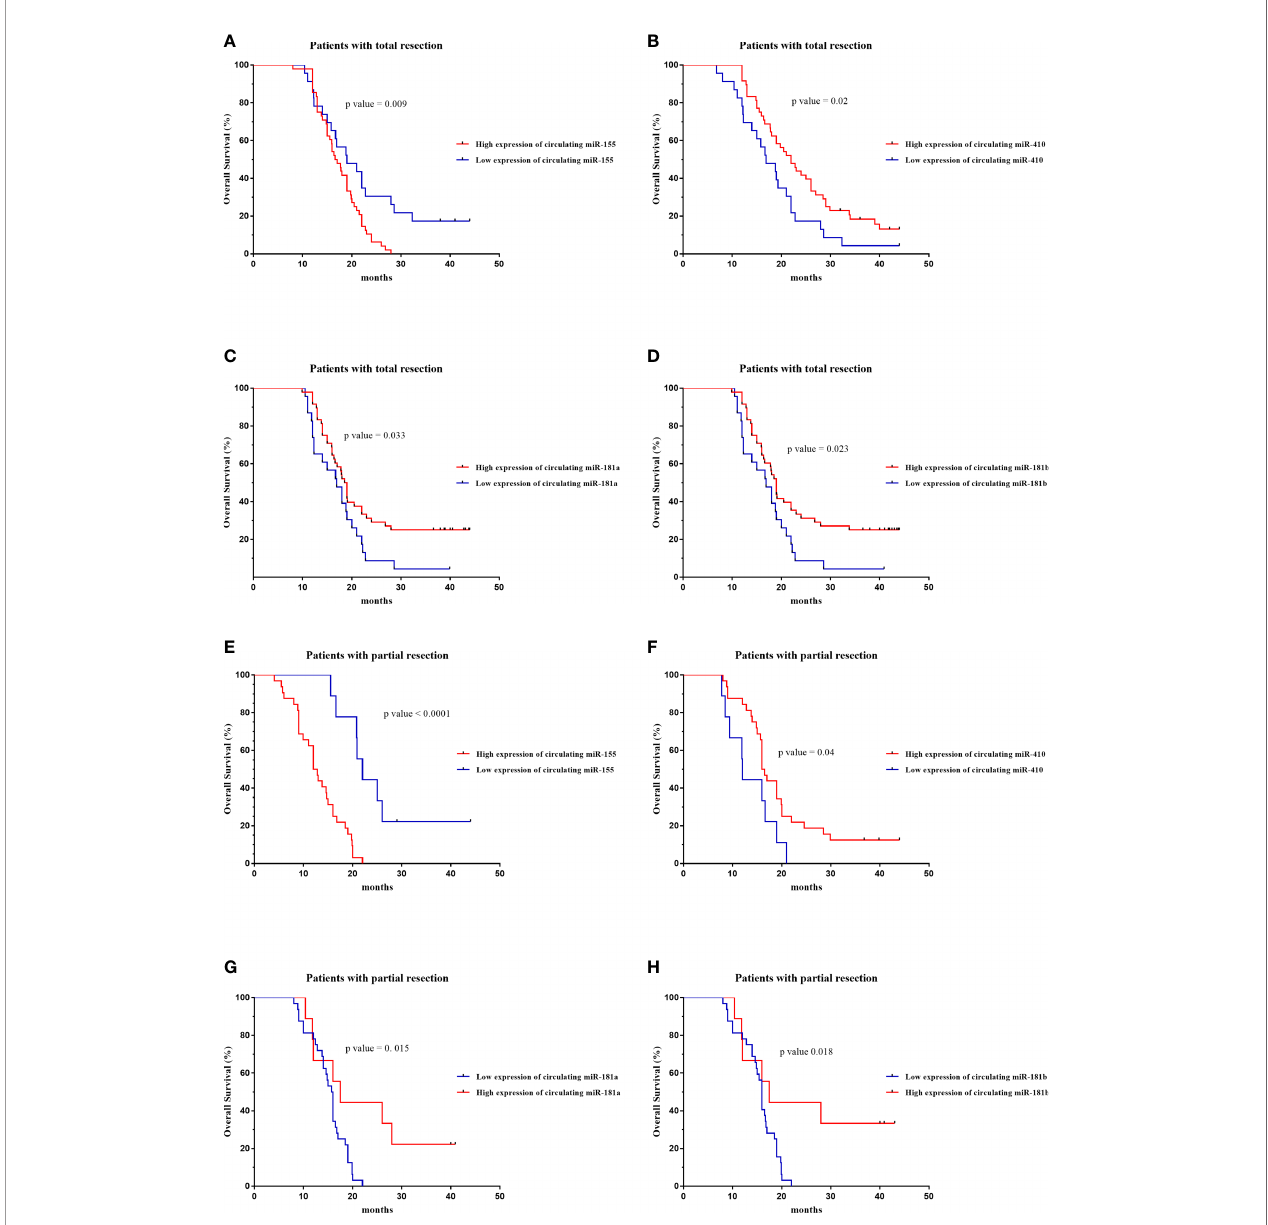
FIGURE 9 | Kaplan – Meier curves of overall survival (OS) for high-grade glioma patients based on the circulating miR-155, miR-410, miR-181a and miR-181b signature in patients with total (n = 71) (A – D) or partial tumor resection (n = 43) (E – H)